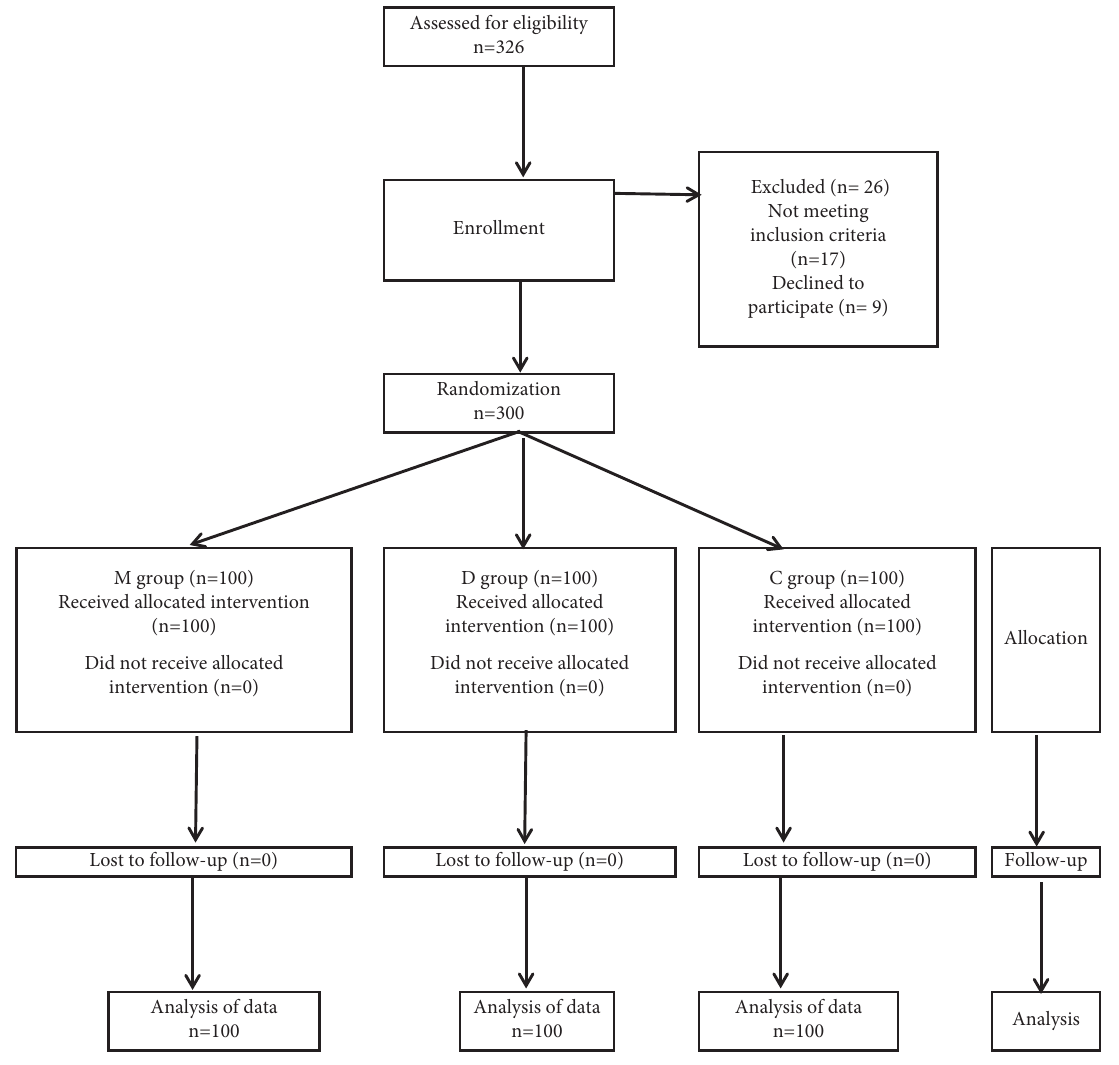
Figure 1: Consort flow